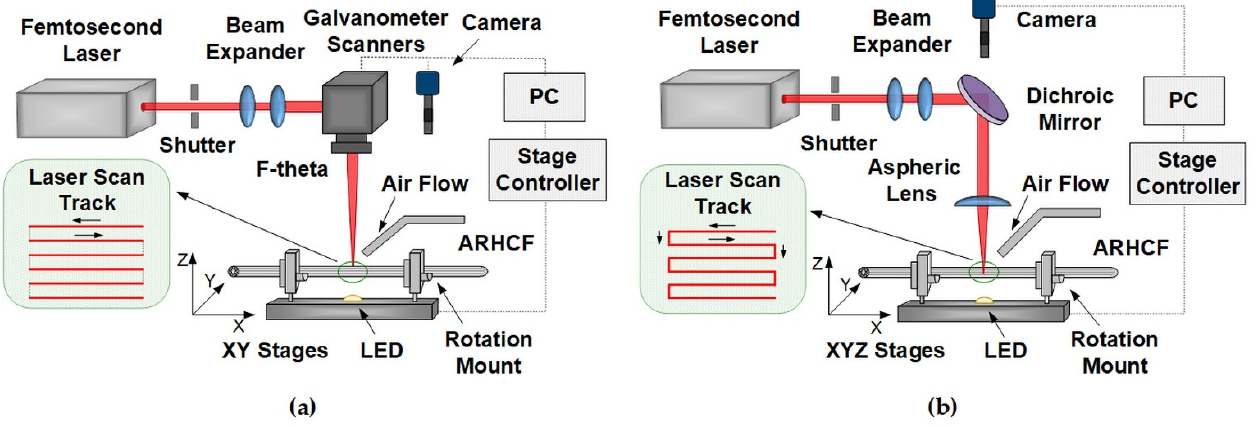
Figure 3. Schematic of the experimental setup for: ( a ) a system with galvanometer scanners and an F-theta lens and ( b ) a moving field and an aspherical lens.